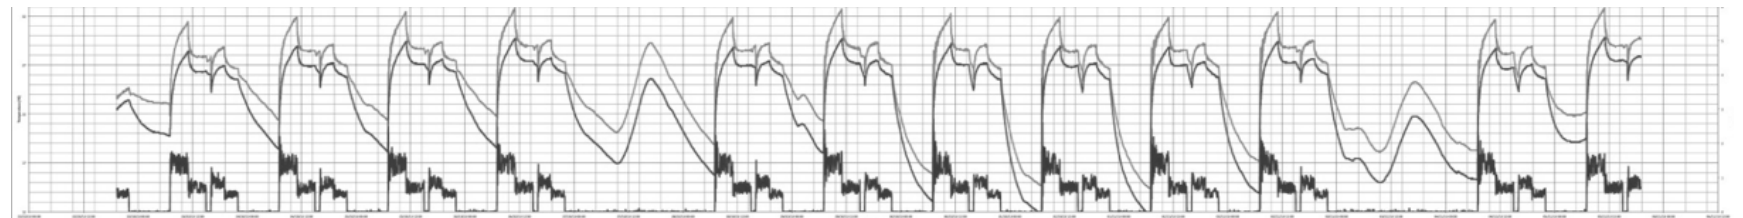
Figure 9. Data recorded from the thermal installation during the